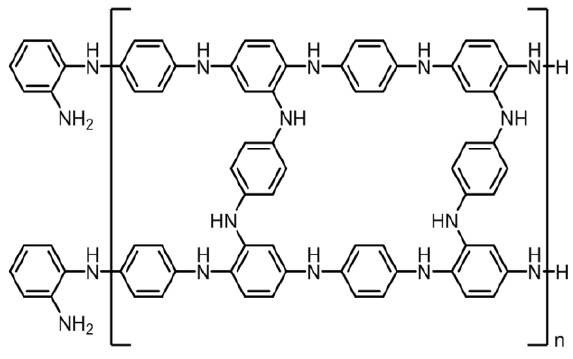
Figure 6. The chemical structure of poly(aniline-co- o -phenylenediamine).